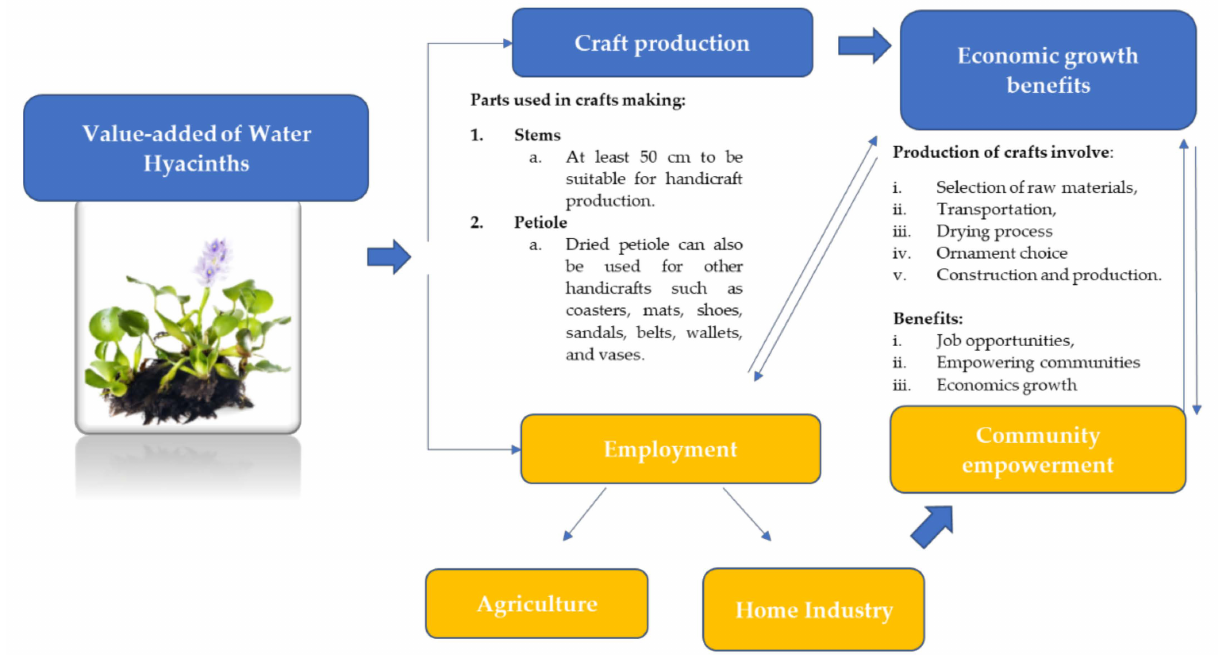
Figure 3. Illustration of value-added water hyacinth to economic growth and community